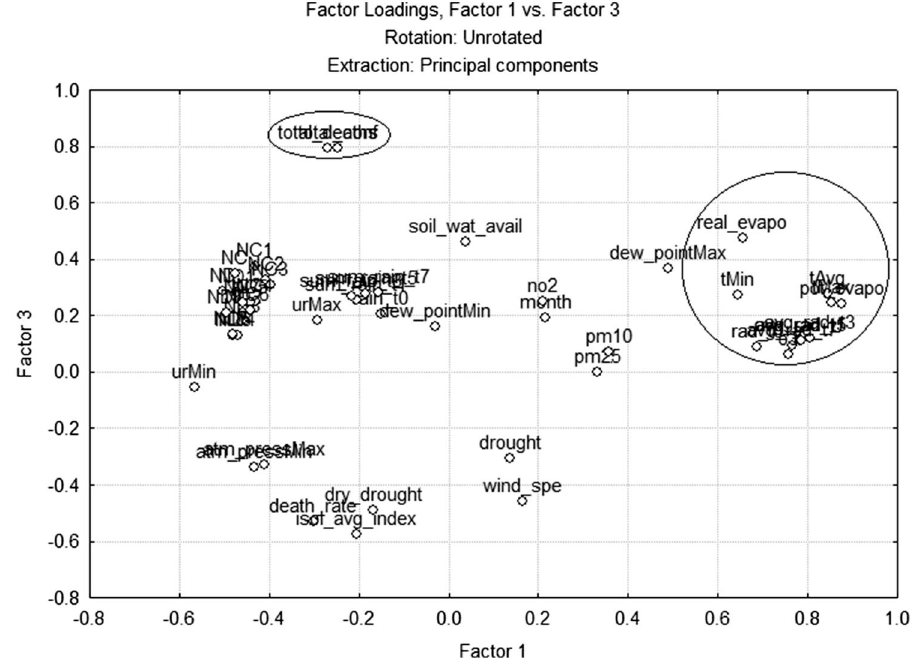
Figure 3. Analysis of the main components in SP(generated by the Statistica 7 software—https:// stati stica. softw are. infor mer. com/).